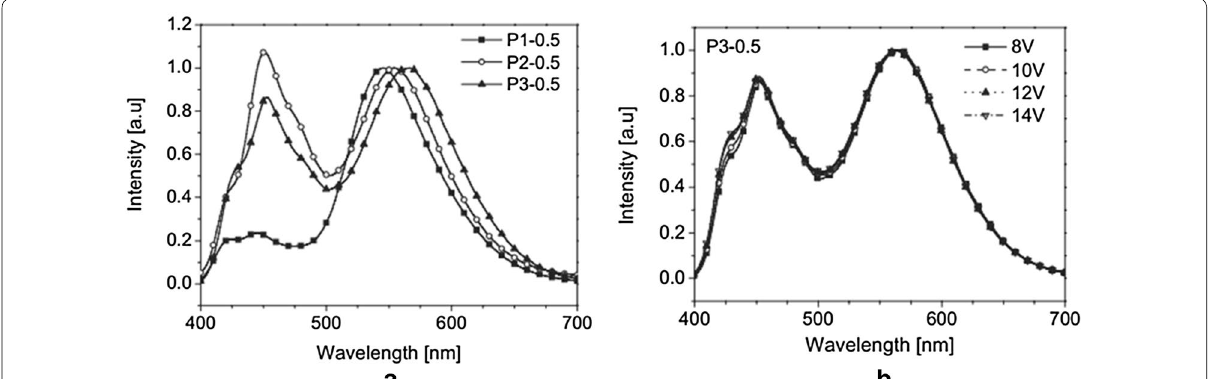
Fig. 11 a EL spectra of the WPLEDs and b EL spectra of P3-0.5 at different driving voltages (Reproduced with permission from Ref. [31] Copyright 2005, ©WILEY–VCH Verlag GmbH &amp; Co. KGaA, Weinheim)